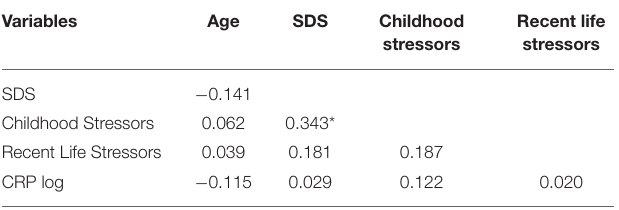
TABLE 2 | Pearson correlations between